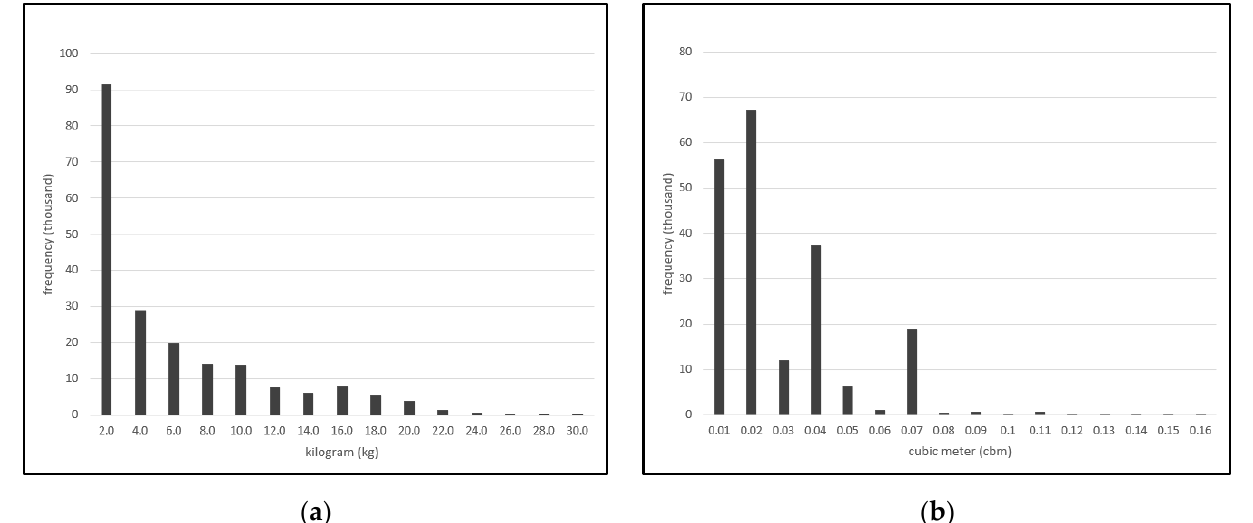
Figure 7. Distribution of delivery weight and volume for an order: ( a ) Delivery weight; ( b ) delivery volume.